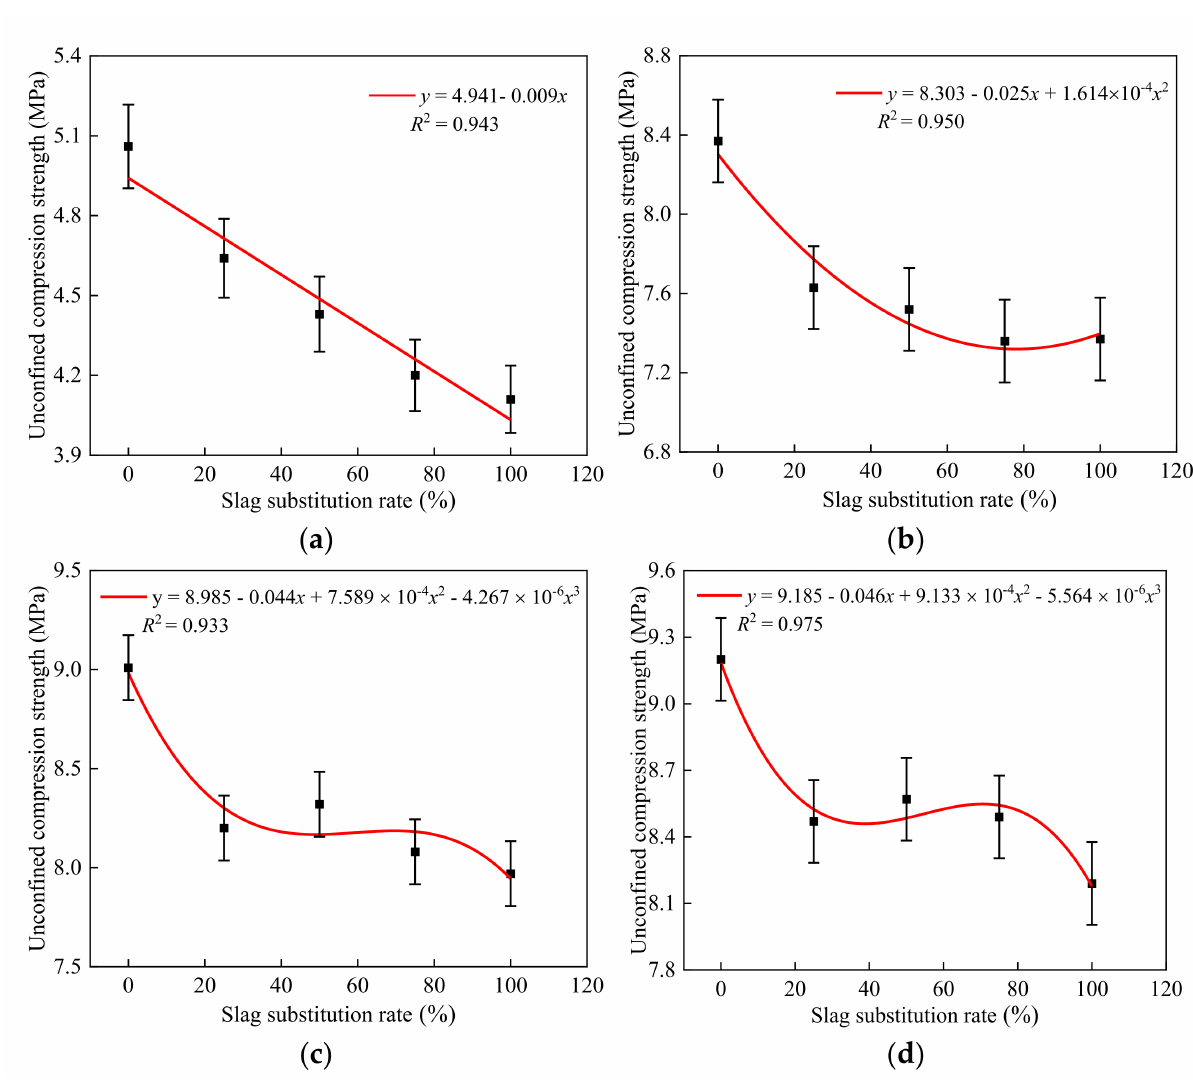
Figure 4. Fitting formulas of the unconfined compressive strength for different furnace slag substitution rates and curing periods: ( a ) 7 days, ( b ) 28 days, ( c ) 56 days, and ( d ) 90